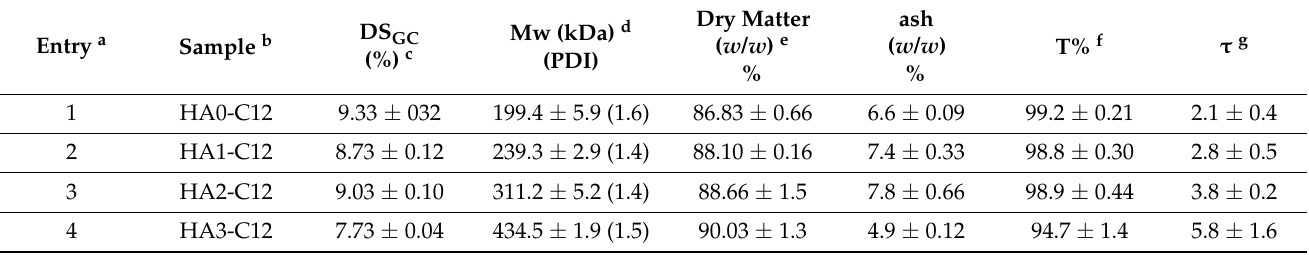
Figure 2. 1 H NMR spectrum of ( A ) Native HA (300 kDa) and esterified HA0-C12 measured in ( B ) D 2 O and ( C ) NaOD. Table 1. Sodium dodecanoyl hyaluronan (HA-C12) studied in this Table 1. Sodium dodecanoyl hyaluronan (HA-C12) studied in this work.